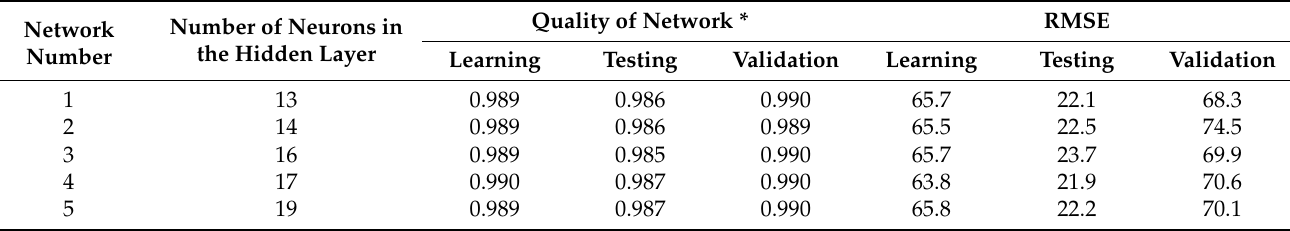
Table 3. Characteristics of the developed neural networks.